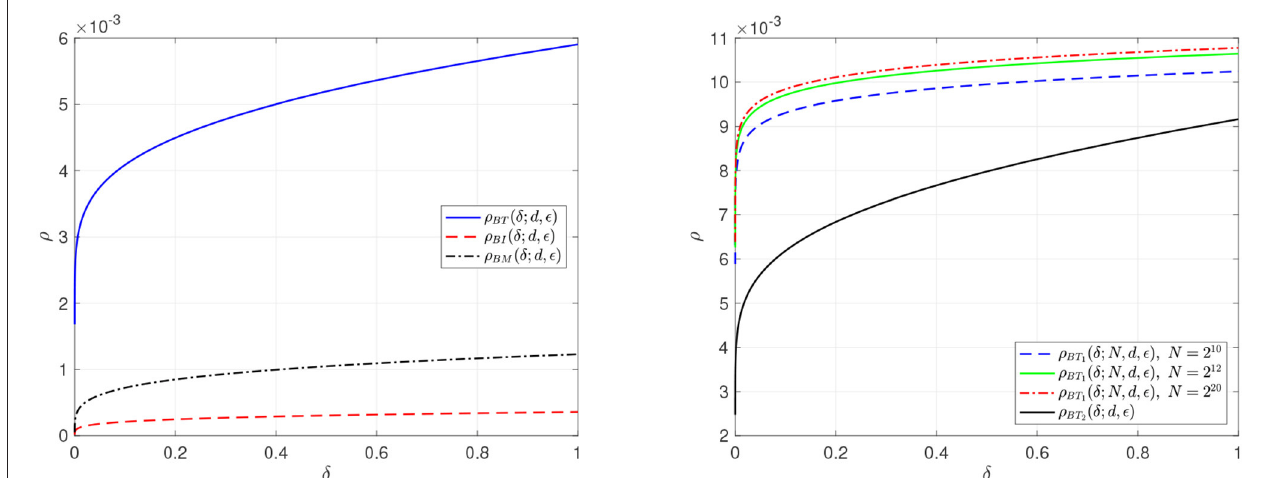
FIGURE 1 | Plots of phase transitions for probabilistic construction of expanders, with fixed d 100 points. (Left) A comparison of ρ BT ( δ previous ρ BT ( δ